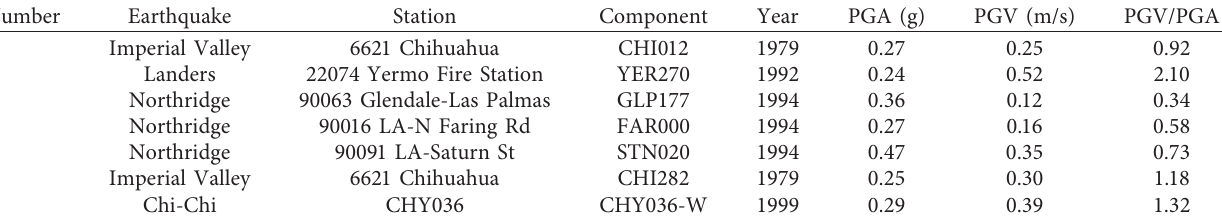
Figure 5: Three typical modal shapes (MIDAS/Civil): (a) first vibration mode; (b) second vibration mode; (c) third vibration mode. Table 3: Selected ground motion